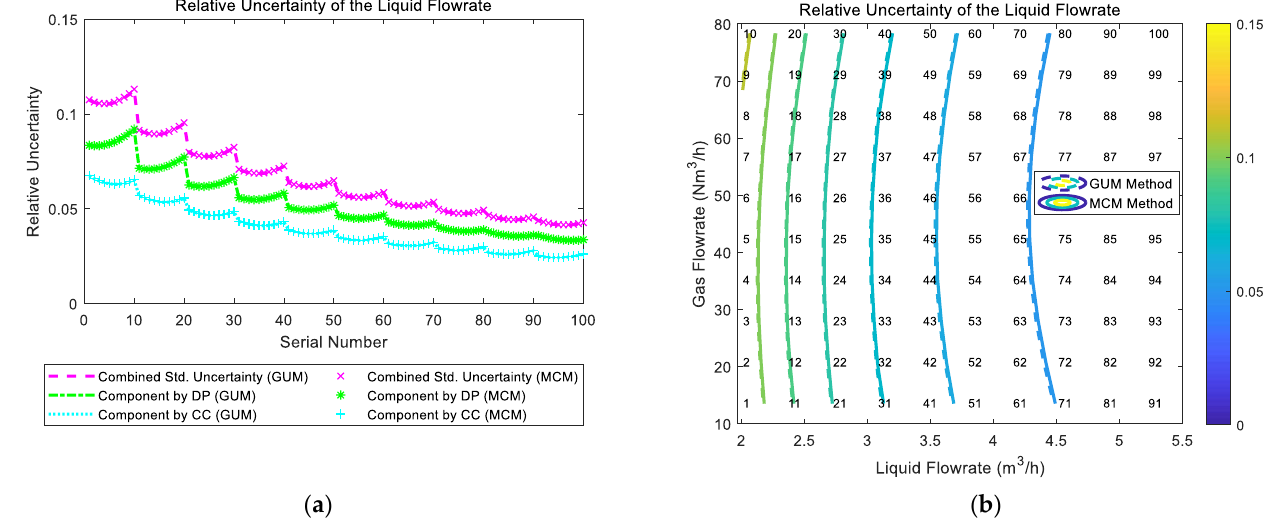
Figure 16. Composition and distribution of the relative uncertainty of the liquid flowrate of the “CC + DP” method: ( a ) composition diagram; ( b ) distribution diagram. (Each contour line denotes an increment of uncertainty of 0.01. More information about the composition and distribution can be found in Section 2.4.1).